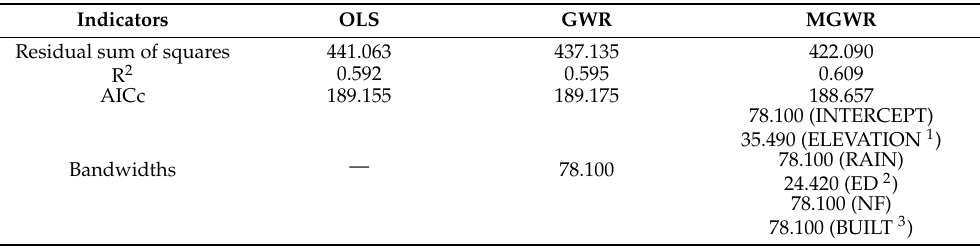
Table 4. Comparison of fit results of low physical fitness regression models for female